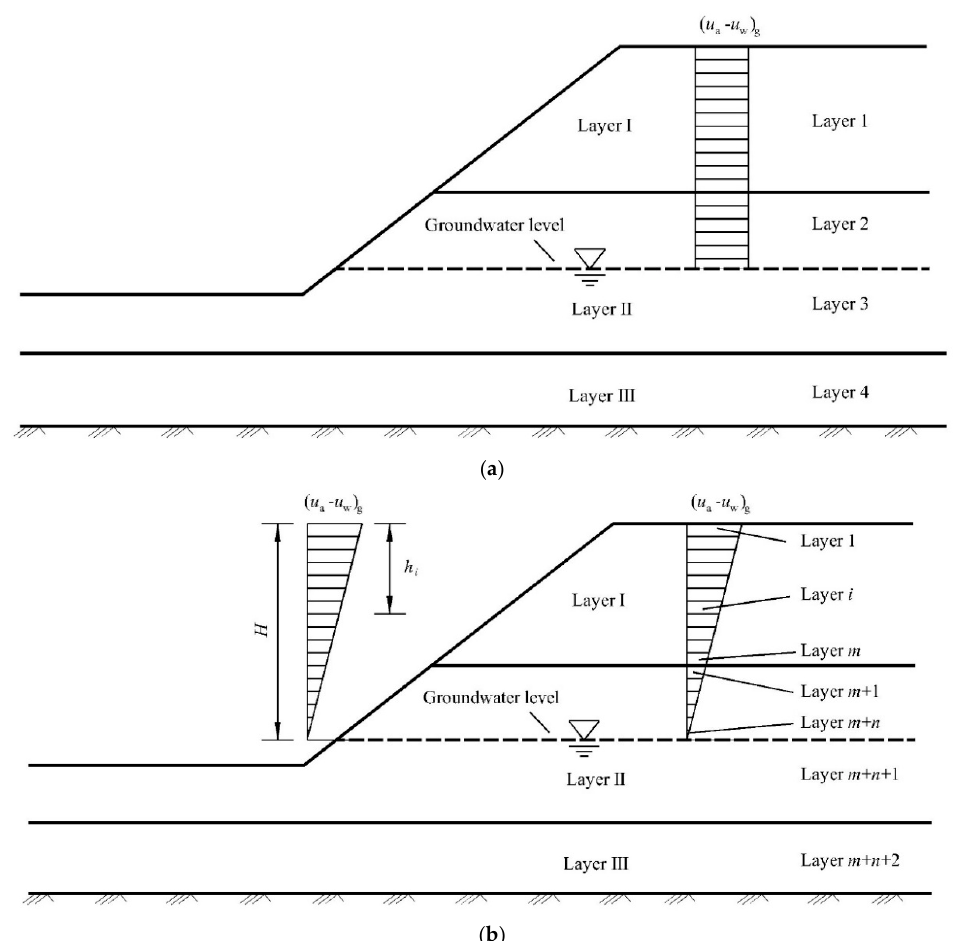
Figure 3. Distributions of the ( u a - u w ) along the depth in unsaturated-multilayered-soil slope ( a ) Distribution I: uniform distribution of ( u a - u w ); ( b ) Distribution II: linear distribution of ( u a - u w ).